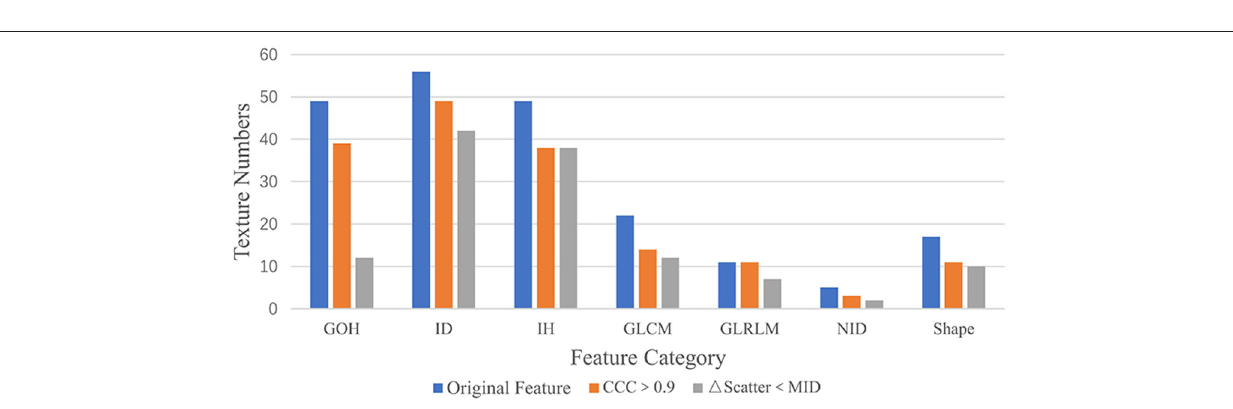
FIGURE 5 | The texture numbers for the seven feature categories. An “Original Feature” is one of the 195 features extracted from 22 patient datasets, “Feature CCC > 0.9” is a feature with a CCC value > 0.9, and “ 1 Feature Scatter < MID” has a delta feature value less than the mean intrapatient difference for a wood